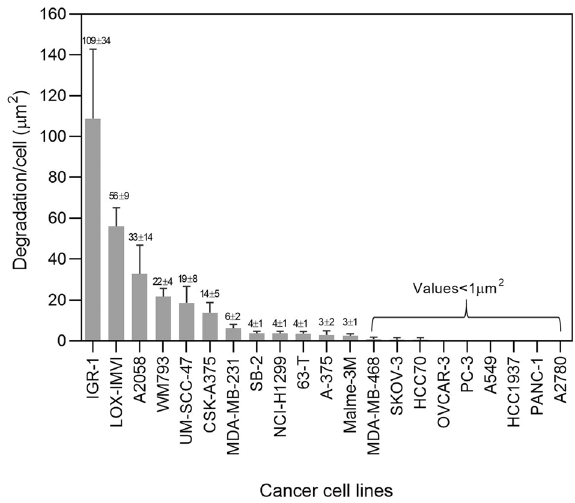
Fig. 2 Quantitation of gelatin matrix degradation in a multi- cancer cell line panel. Cells were seeded on FITC labeled gelatin matrix and cultured for 5 – 6 h. Subsequently, the cells were fi xed with 3% paraformaldehyde in PBS and stained for actin and DAPI. Each cell line was seeded in duplicate wells. Images were acquired using 40×/0.75 air objective. 36 fi elds were imaged per well and the gelatin degradation/cell (µm 2 ) was quantitated using ImageJ soft- ware. The plot shows the average of four independent data sets with ±SEM. The p value was found to be (<0.0001). Four independent sets of experiments were performed and the average plot is shown. These cell lines then served as platform for further experiments in this